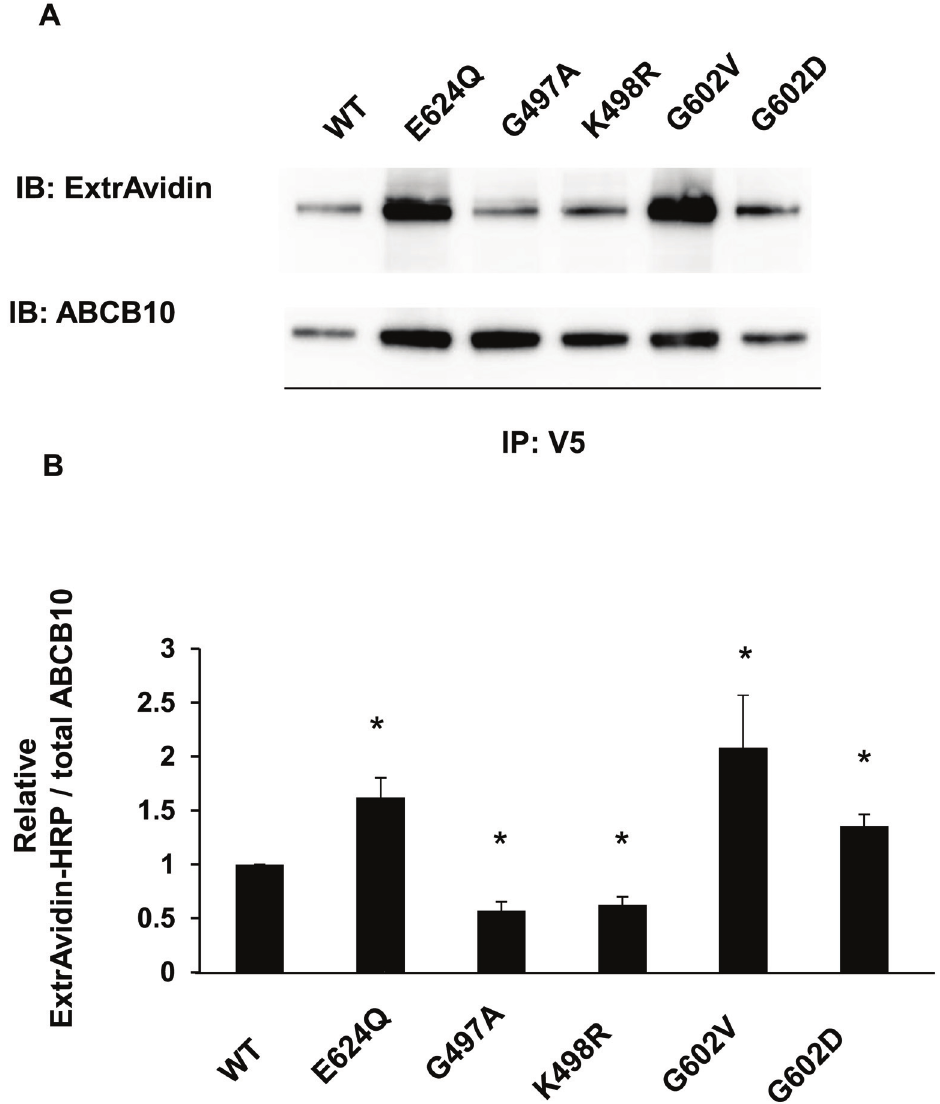
Fig 4. Mutations in ABCB10 NBD changed 8-azido-ATP-[ γ ]-biotin photolabeling according to their expected effects on ATP binding and/or hydrolysis. A) Representative Western blot analysis of SMPs from HEK293 cells transfected with wild type murine ABCB10 (WT) and different mutants (E624Q in Walker B; G497A in Walker A; K498R in Walker A; G602V in Loop C; G602D in Loop C) were photolabeled with 8-azido-ATP [ γ ] biotin detected with ExtrAvidin-HRP. Total ABCB10 pulled down in the V5-immunoprecipitate was detected by Western blot using a polyclonal ABCB10 antibody. B) Relative 8-azido-ATP [ γ ] biotin photolabeling intensity, which is consequence of both ABCB10 ATP binding and hydrolysis activity, was normalized to ABCB10 total levels, considering the different ABCB10 expression levels in different mutants. The values are shown relative to wild type ABCB10. Mutations in Walker A expected to primarily affect ATP binding decreased relative Extravidin-HRP signal by ~40%, while mutations expected to selectively affect hydrolysis but not binding (Walker B and Loop C) increased the signal. The bar graph shows the relative ExtrAvidin-HRP signal. Three independent experiments were conducted and data are shown as mean ± SEM. * p < 0.05 vs. signal in wt